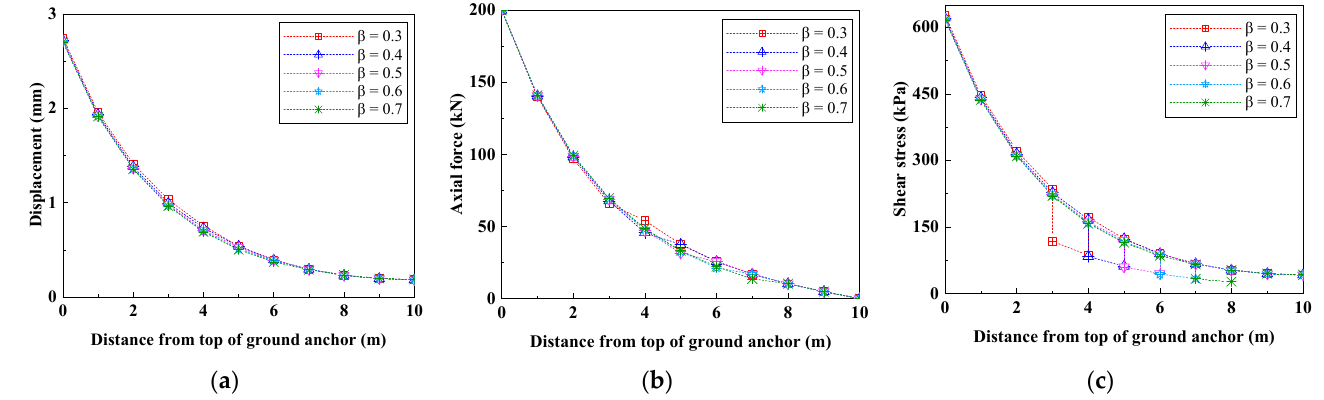
Figure 15. Effect of the depth of stratum interface on mechanical behavior of ground anchor. (Case 2: condition 6) ( a ) displacement distribution curve; ( b ) axial force distribution curve; ( c ) shear stress distribution curve.